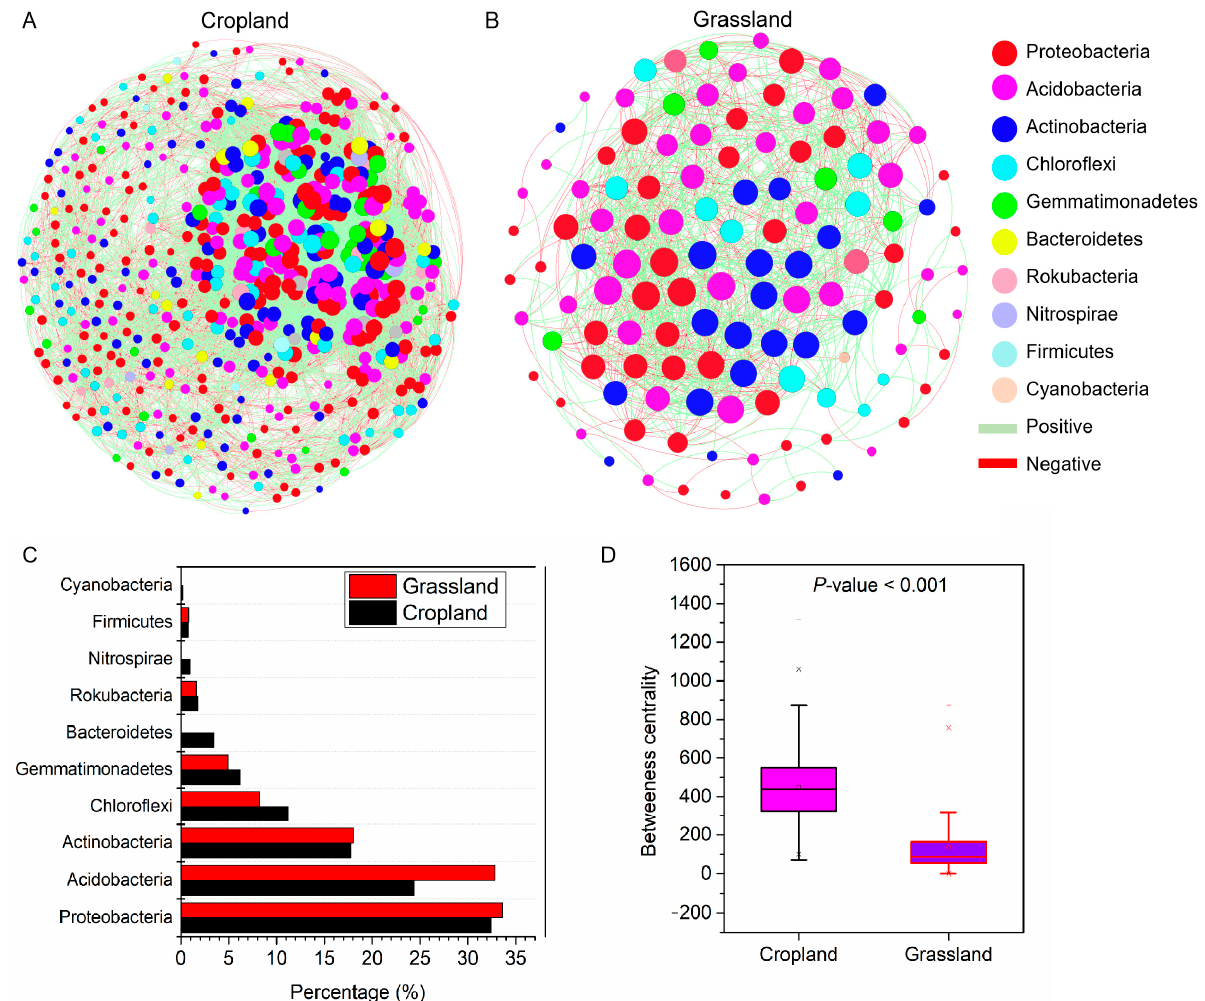
Figure 6. Co-occurrence networks of bacterial communities at the OUT level in the soil of cropland ( A ) and grassland ( B ) based on a Spearman correlation (|r| > 0.7, p < 0.05). The percentage of dominant bacteria in the networks ( C ). The difference in betweenness centrality of the network between cropland and grassland ( D ).